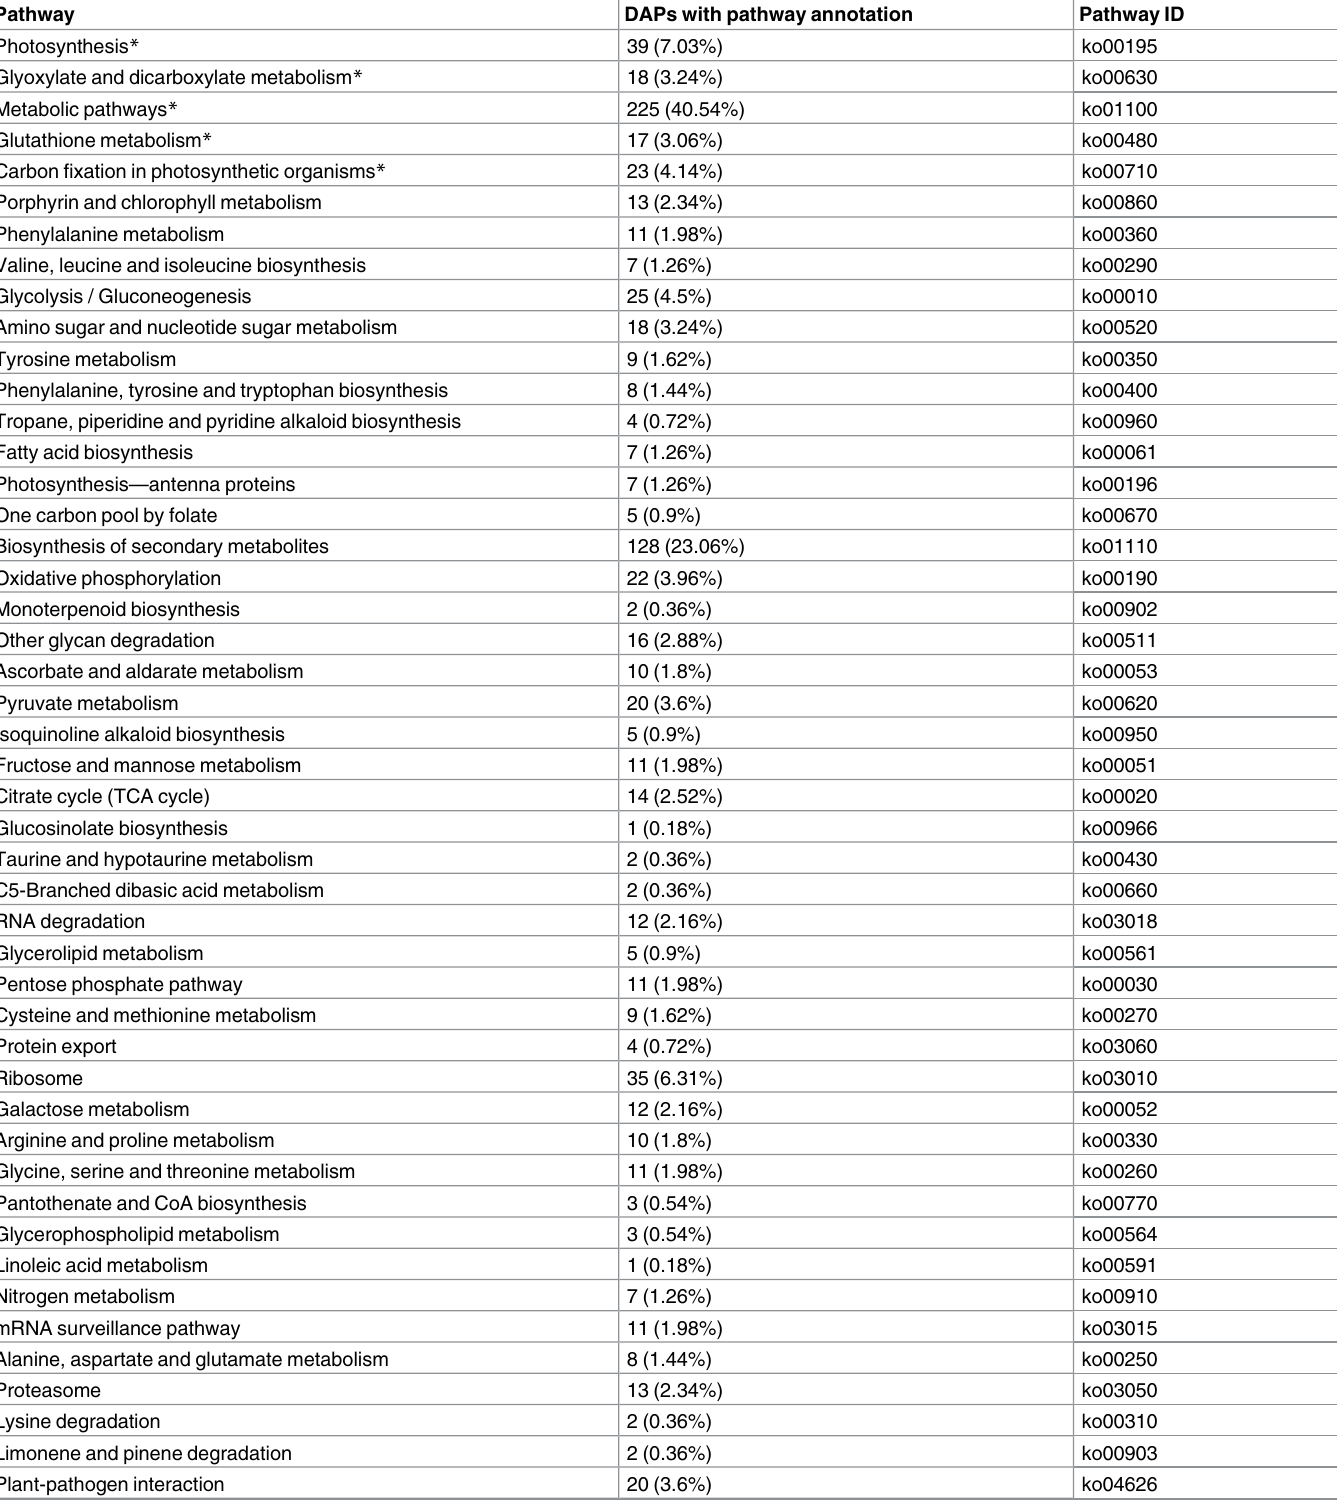
Table 1. KEGG pathway enrichment analysis of the differentially abundant proteins in PA2 vs .